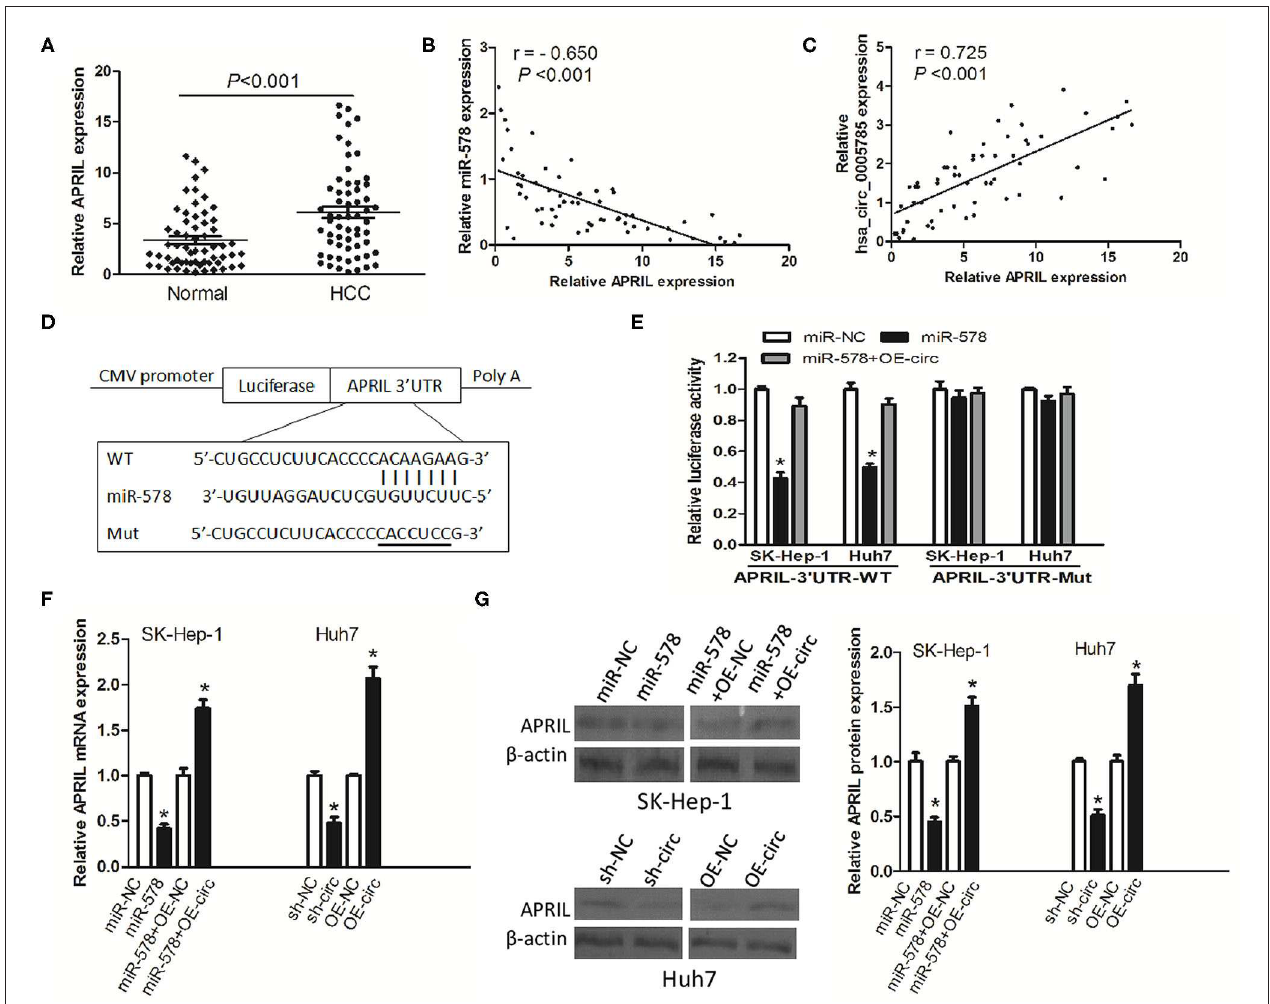
FIGURE 6 | hsa_circ_0005785 regulates the expression of APRIL, an mRNA target of miR-578. (A) qRT-PCR detection of APRIL mRNA expression in 60 HCC tissues and paired normal tissues. Correlation analyses of miR-578 vs. APRIL mRNA expression levels (B) , and hsa_circ_0005785 vs. APRIL mRNA expression levels (C) from 60 HCC tissues. (D) Bioinformatics software predicted the miR-578-binding sequence of APRIL mRNA 3 ′ UTR, and its wild-type (WT) or mutant (Mut) miR-578-binding sequence was cloned into the pMIR luciferase reporter. (E) Luciferase activity was analyzed in two HCC cell lines co-transfected with miR-NC, miR-578 mimic, or miR-578 mimic + OR-circ, together with APRIL mRNA 3 ′ UTR-WT or 3 ′ UTR-Mut. qRT-PCR (F) and Western blot (G) analyses of APRIL mRNA and protein expressions in miR-NC-, miR-578 mimic-, miR-578 mimic + OR-NC-, or miR-578 mimic + OR-circ-treated SK-HEP-1 cells, and in sh-NC-, sh-circ-, OE-NC-, or OE-circ-treated Huh7 cells, respectively, * P <